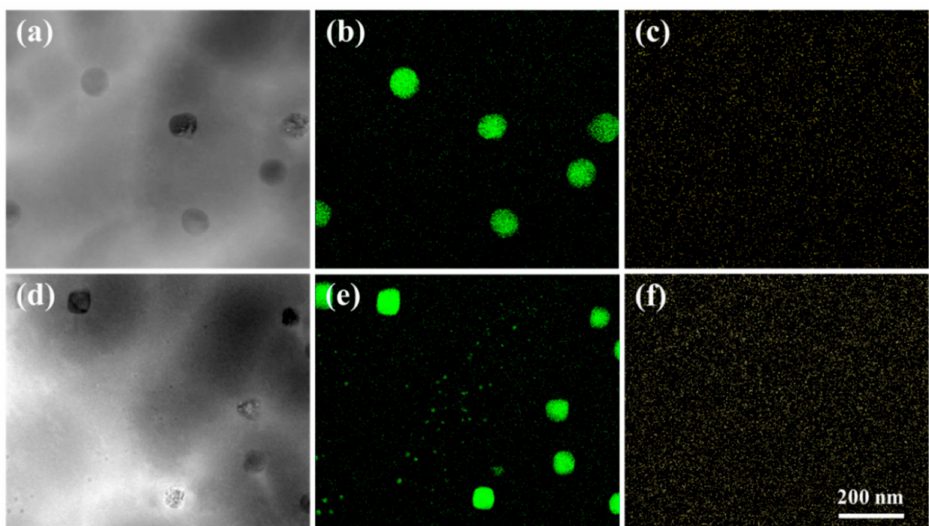
Figure 8. Scanning transmission electron microscopy high-angle annular dark-field (STEM-HADDF) imagesof( a )C00and( d )C01specimens, respectively, ( b , c )elementalmappingofFeandCcorresponding to ( a ) and ( e , f ) elemental mapping of Fe and C corresponding to ( d